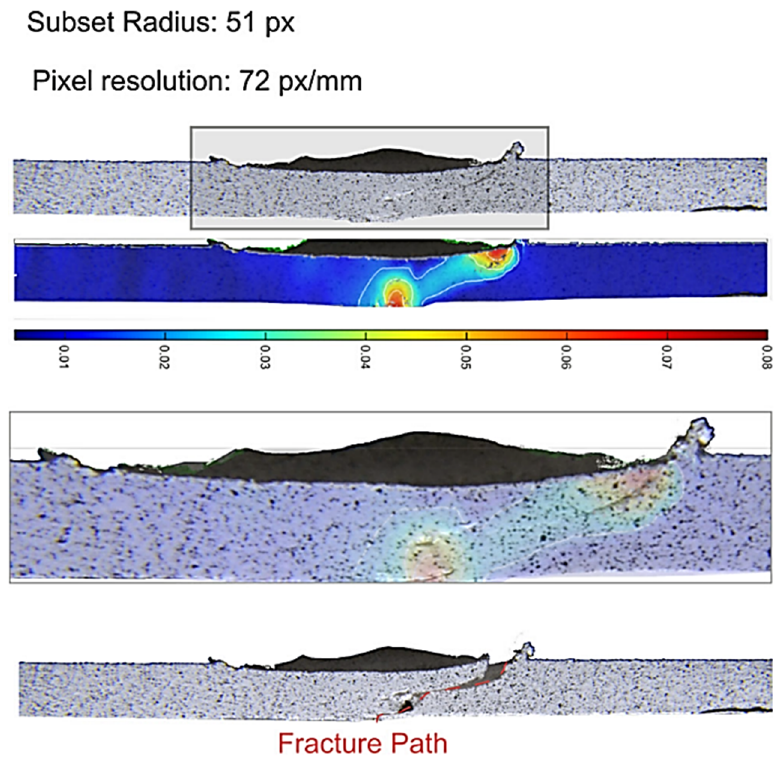
Figure 9. Details of prepared samples for digital image correlation (DIC) analysis during tensile tests [34].